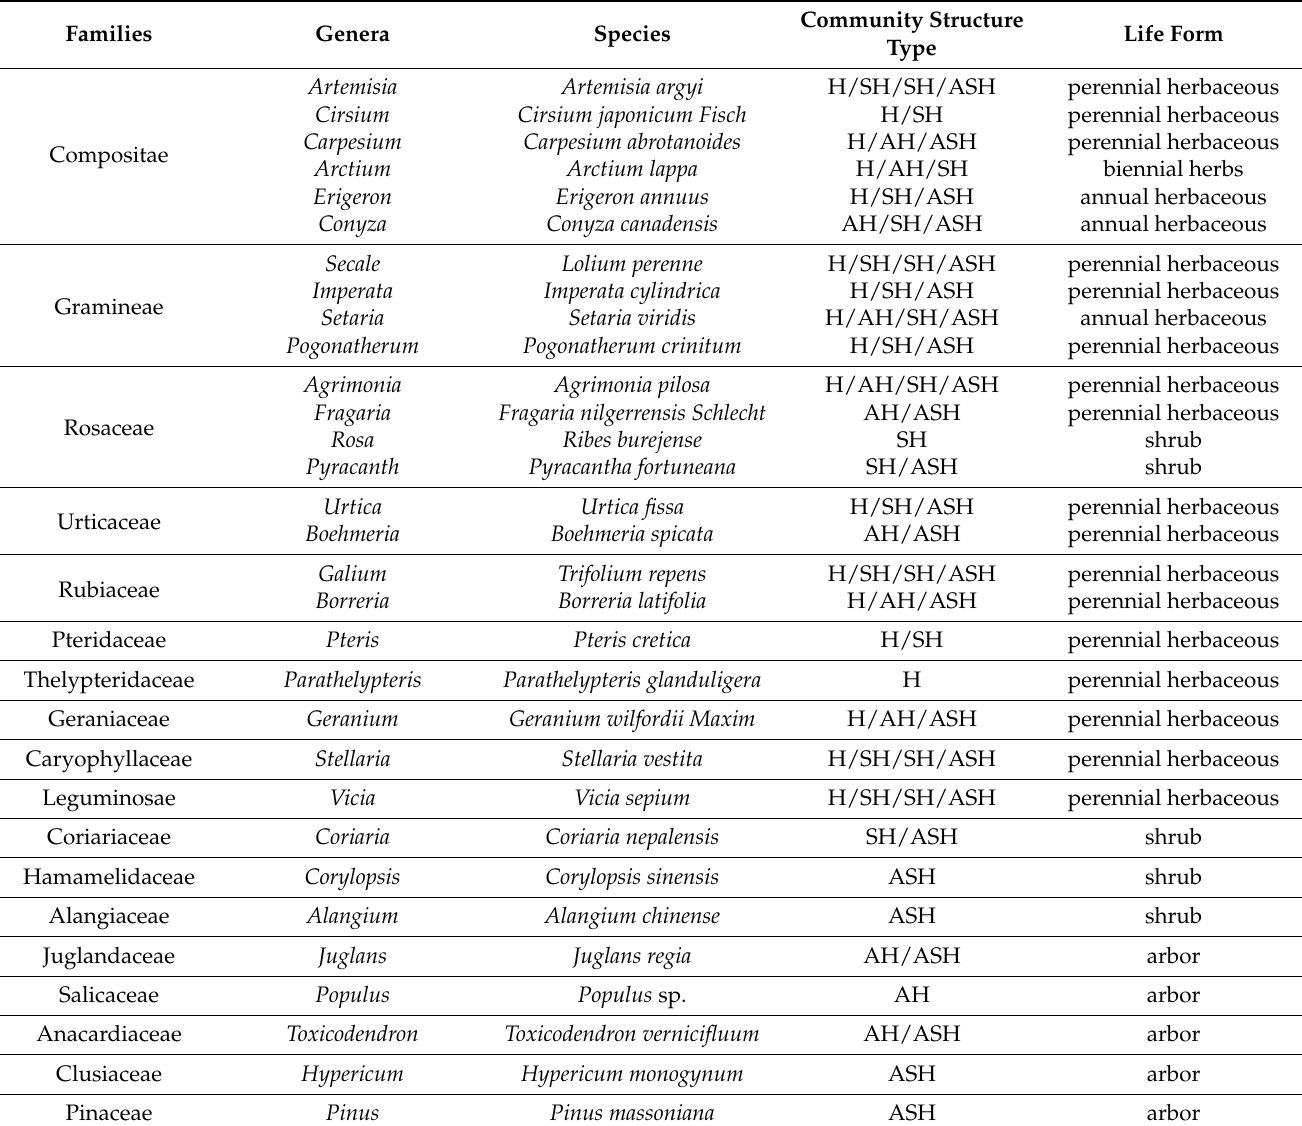
Table 3. The species composition of plant